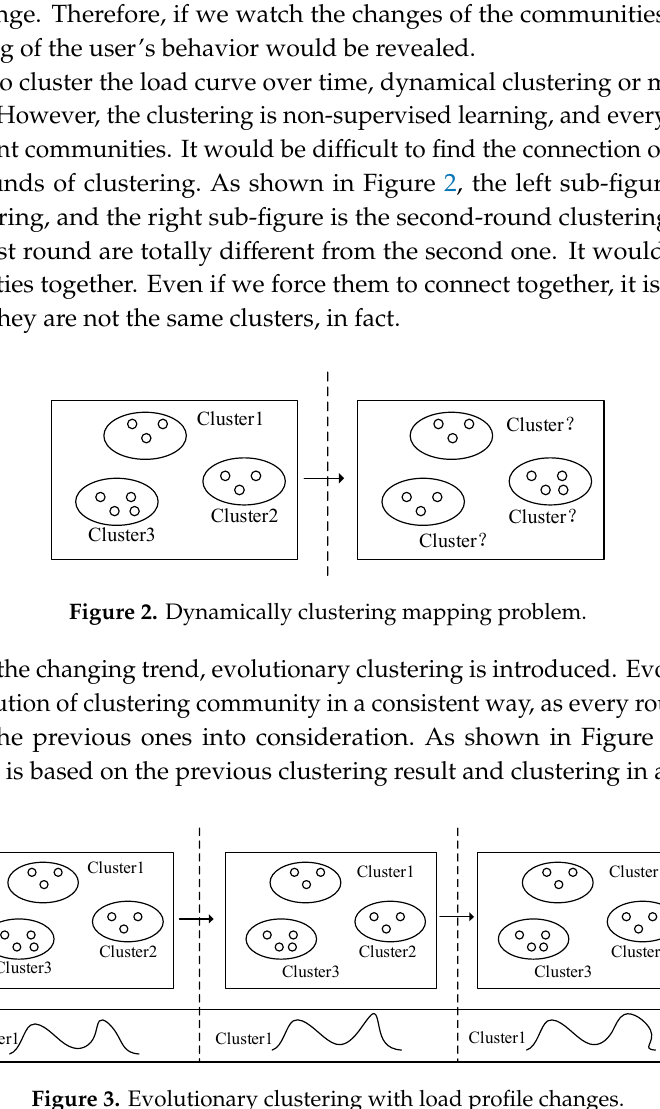
Figure 3. Evolutionary clustering with load profile changes.